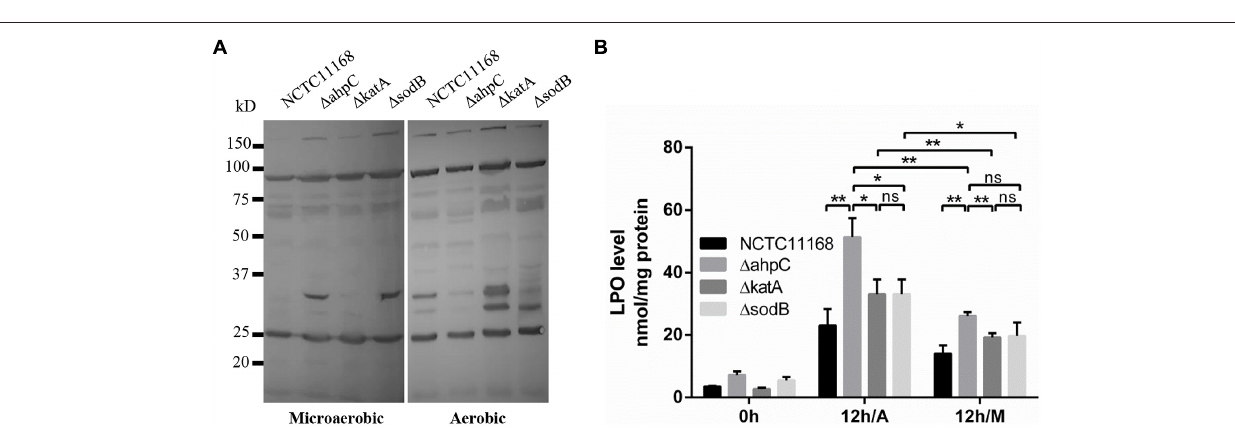
were determined after 12 h culture under aerobic conditions (12 h/A) and 12 h under microaerobic conditions (12 h/M). Results shown are the means and SD of triplicate samples. The experiment was repeated three times and all results produced similar results. Statistical significance was determined by one-way ANOVA using GraphPad Prism 6. ∗ P < 0.05, ∗∗ P < 0.01, ns, P >